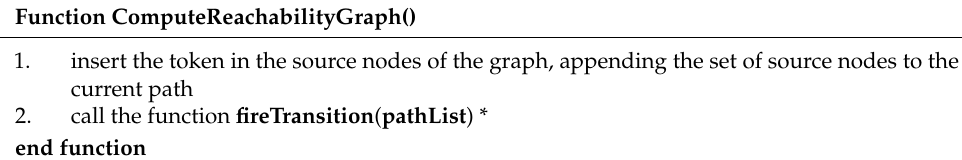
Table 2. The algorithm in pseudo-code adopted to navigate the HIN and define the reachability